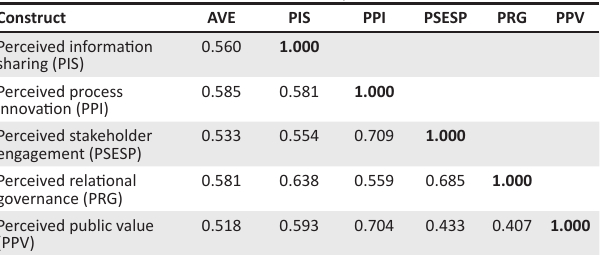
TABLE 4: Correlations and discriminant validity. Construct AVE PIS PRG